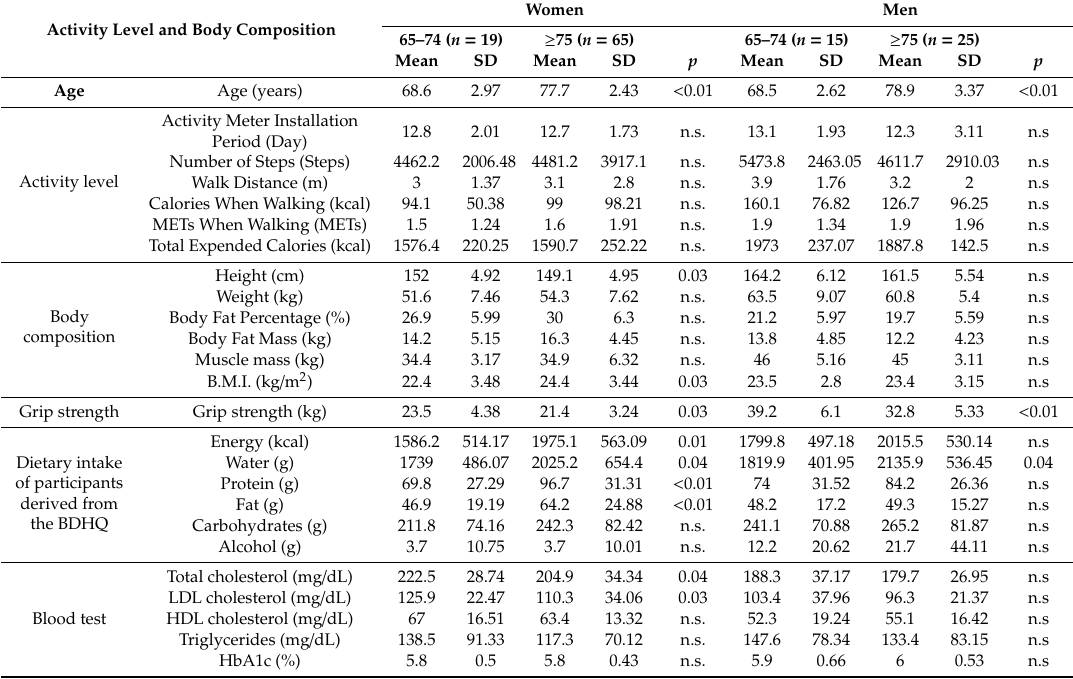
Table 1. Comparison of activity level and body composition between the 65–74 age group and the ≥ 75 age